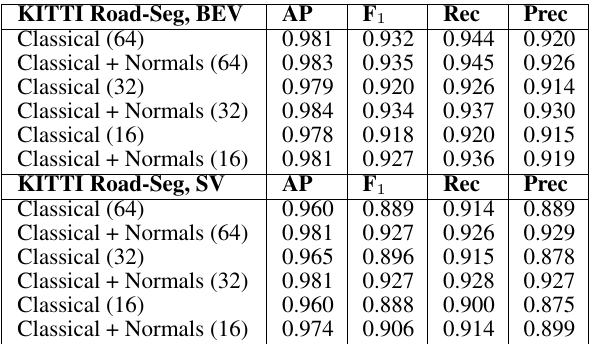
Table 2. Results obtained on the test set of the KITTI road segmentation dataset in the BEV and SV.